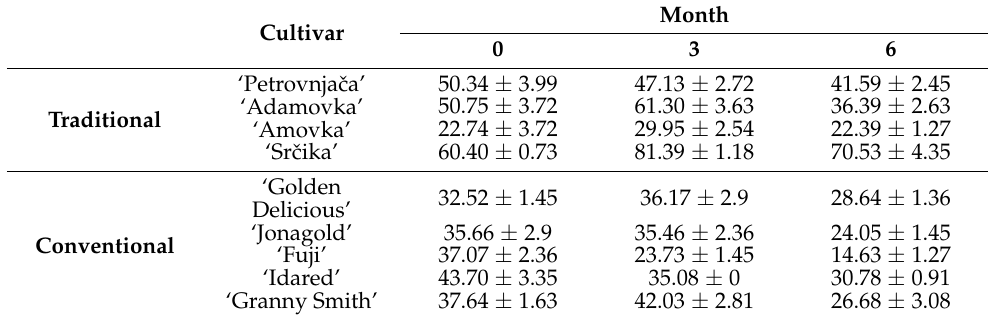
Table 1. Total polyphenol content (mg/100 g DW) in the traditional and conventional apple cultivars.